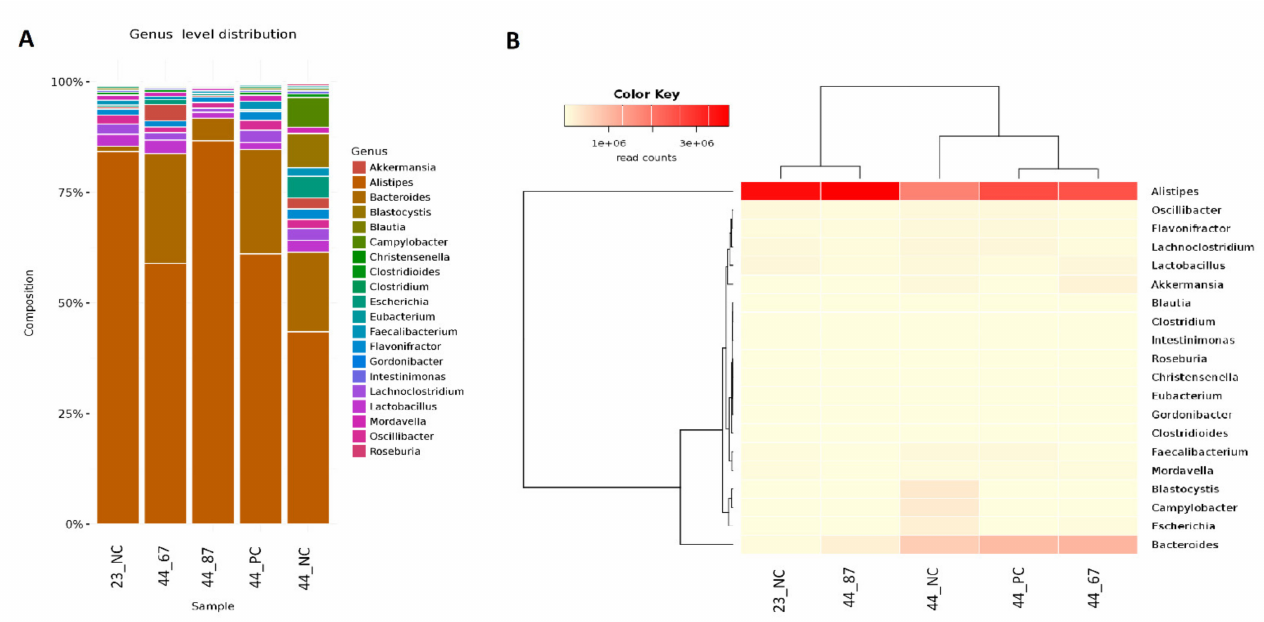
Figure 2. ( A ) The abundance of the genera and their relationships across the samples. ( B ) Dendrograms determined by computing hierarchical clustering from the abundance levels, showing the relationship between the genera (left) and the samples (top). The abundance levels (number of reads associated with each taxa) were logarithmically transformed to base 2 for clarity.